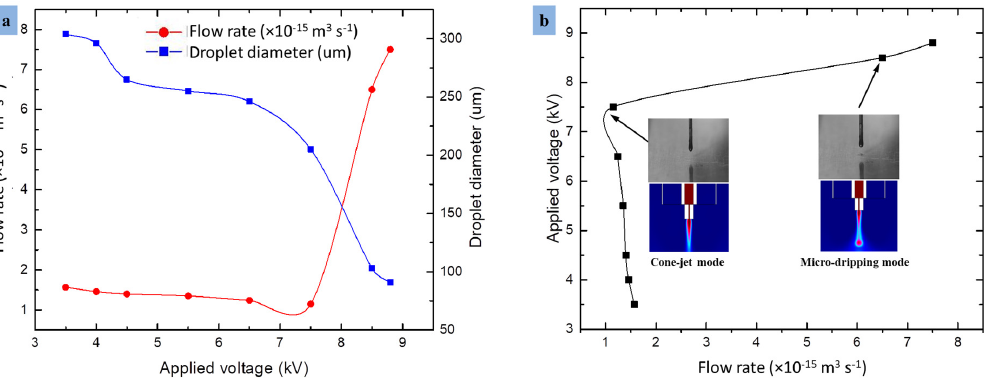
Figure 8. ( a ) Droplet-size dynamic curve at different applied voltages and flow rates, ( b ) comparison of cone-jet formation and microdripping